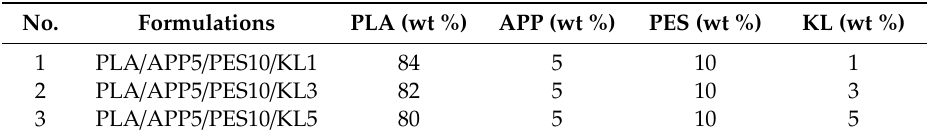
Table 2. Additives composition in PLA